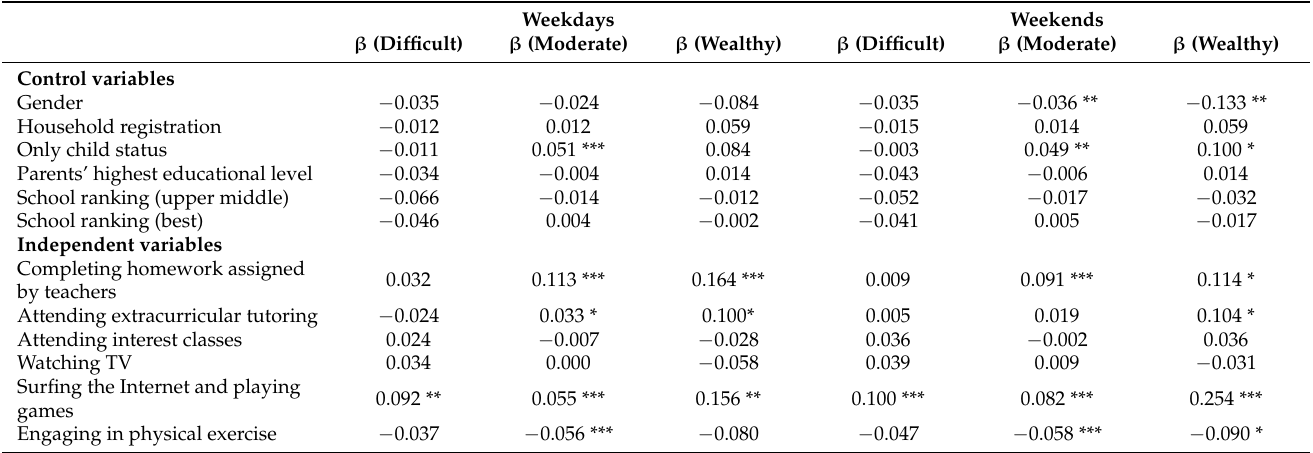
Table 6. Effects of extracurricular activities on depressive symptoms in different family economic status groups.